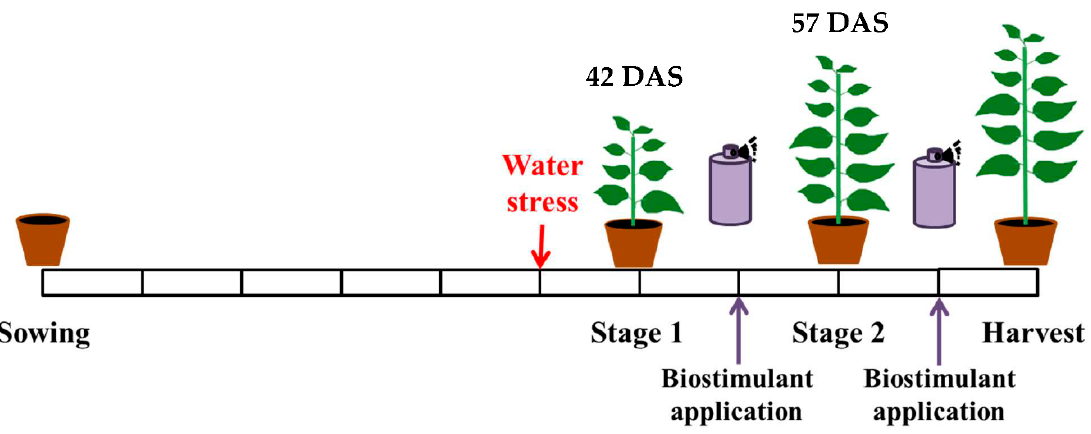
Figure 1. Schematic representation of the experimental. One rectangle represents one week.